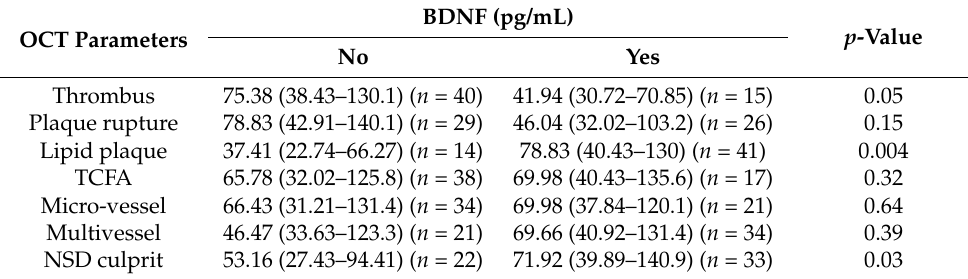
Table 2. Plasma BDNF levels according to OCT features in CAD patients.